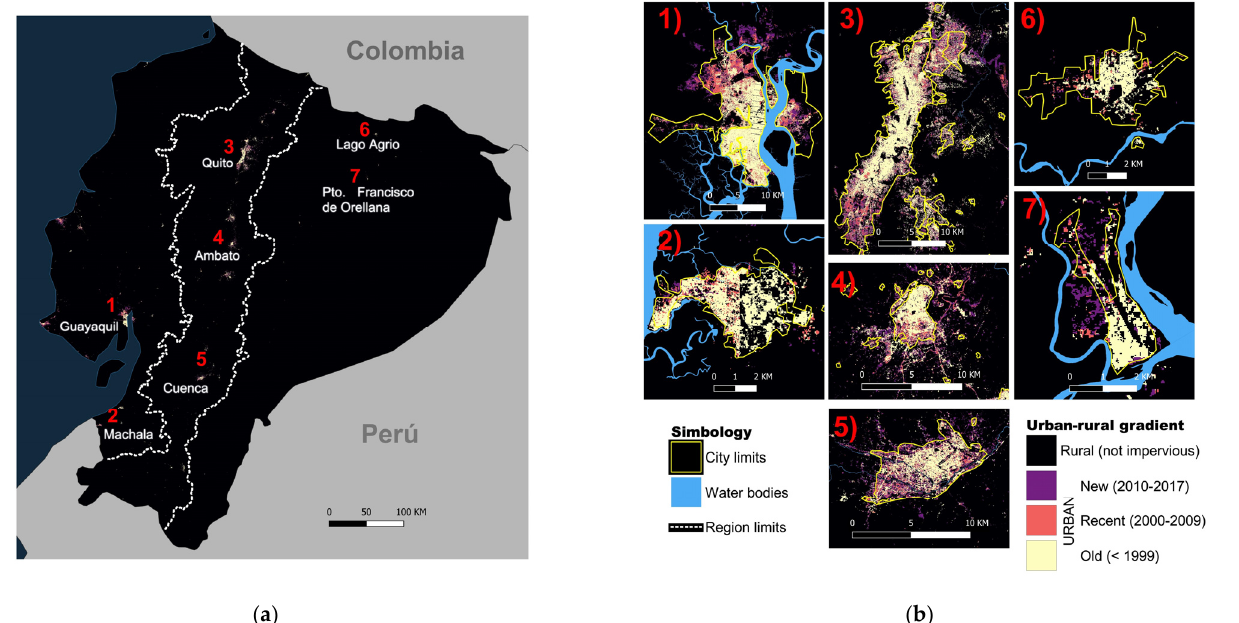
Figure 2. ( a ) Urban–rural gradient map for continental Ecuador, modified following Gong et al. [38]. Recent and new urban areas are shown in purple, and old areas are shown in yellow. ( b ) Map panels showing the largest cities. The first column shows Guayaquil and Machala in the coastal region (1,2); the second column shows Quito, Ambato, and Cuenca in the Andes (3–5); and the third column shows Lago Agrio and Puerto Franscisco de Orellana in the Amazon (6,7).